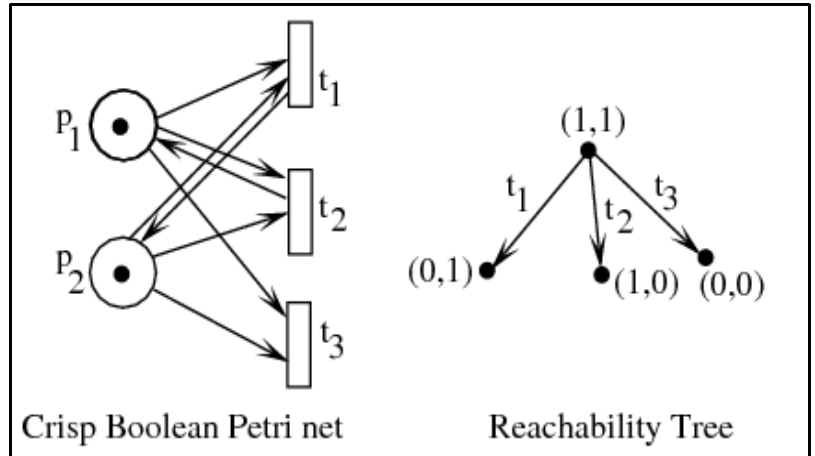
Figure 3. Crisp boolean Petri net and its reachability